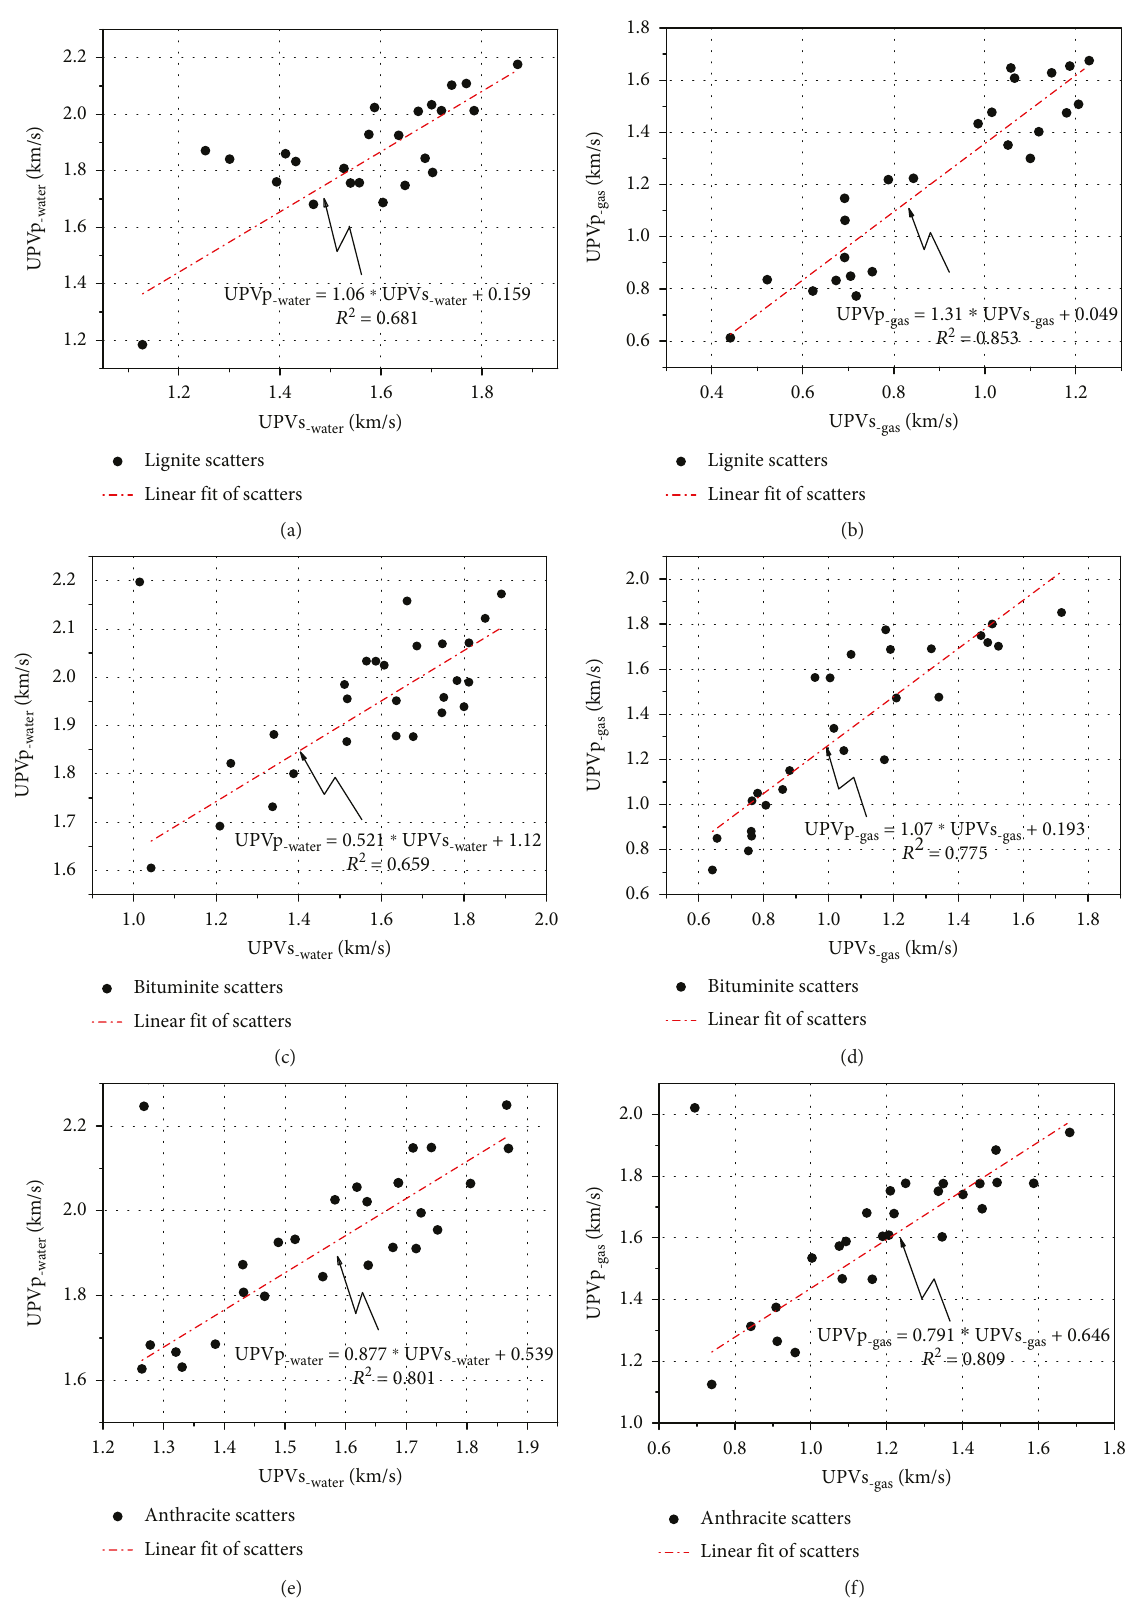
Figure 4: Scatterplot of velocity data and goodness-of- fi t correlations between UPVs and UPVp of lignite, bituminite, and anthracite cores under water and gas